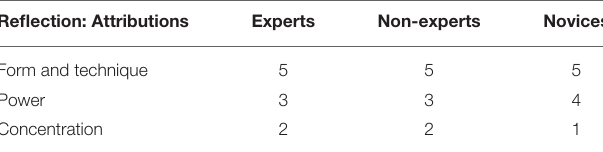
TABLE 8 | An overview of attribution types across the three skill levels.